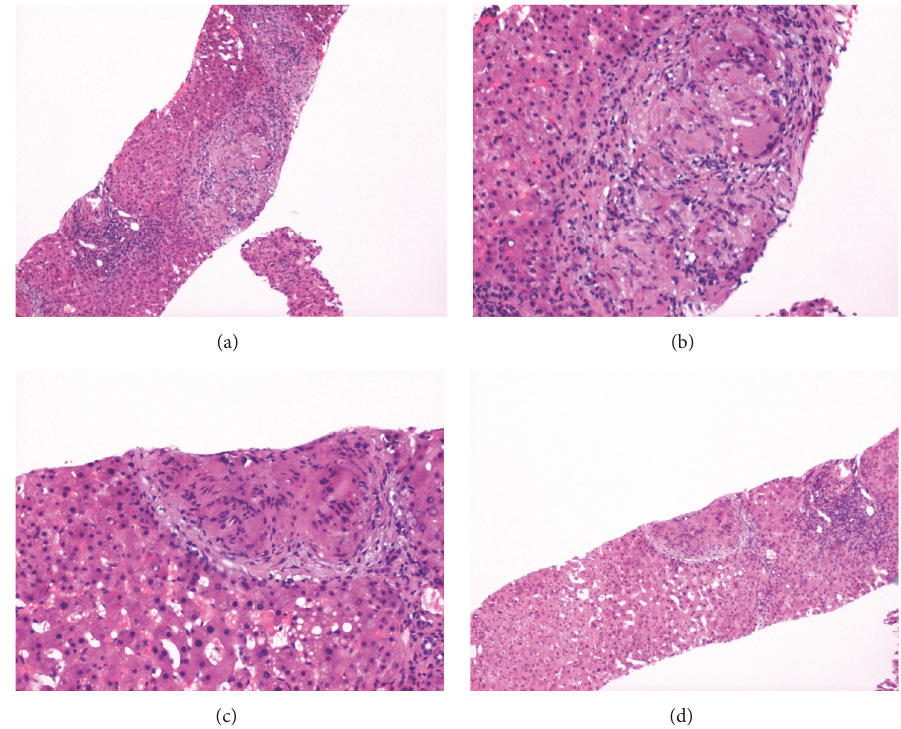
Figure 2: Liver biopsy, 2015. (a) Liver, H+E, 40x, low power view showing liver parenchyma with focal replacement by noncaseating granulomas.(b)Liver,H+E,200X,highpowerviewdemonstratingnoncaseatinggranulomasandgiantcells.(c)Liver,H+E,200X,highpower view demonstrating noncaseating granulomas and giant cell. (d) Liver, H+E, 40x, low power view demonstrating noncaseating granuloma